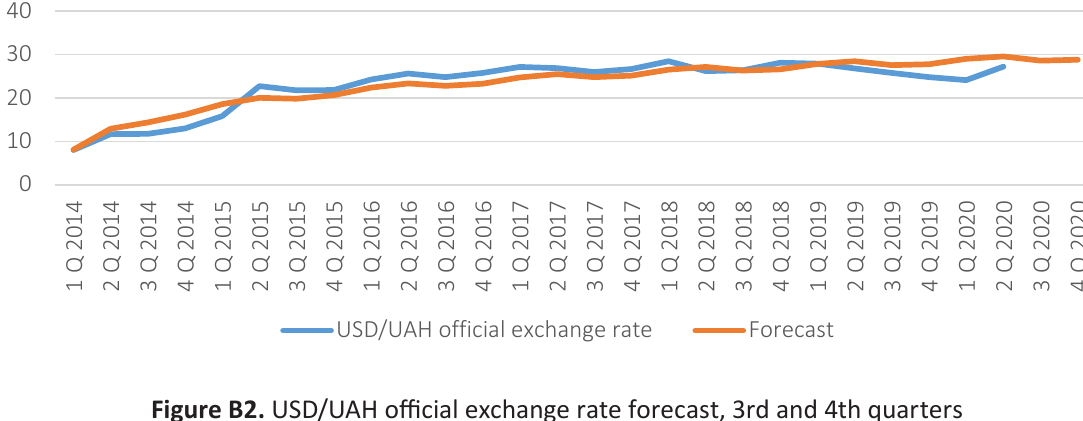
Figure B2. USD/UAH official exchange rate forecast, 3rd and 4th quarters